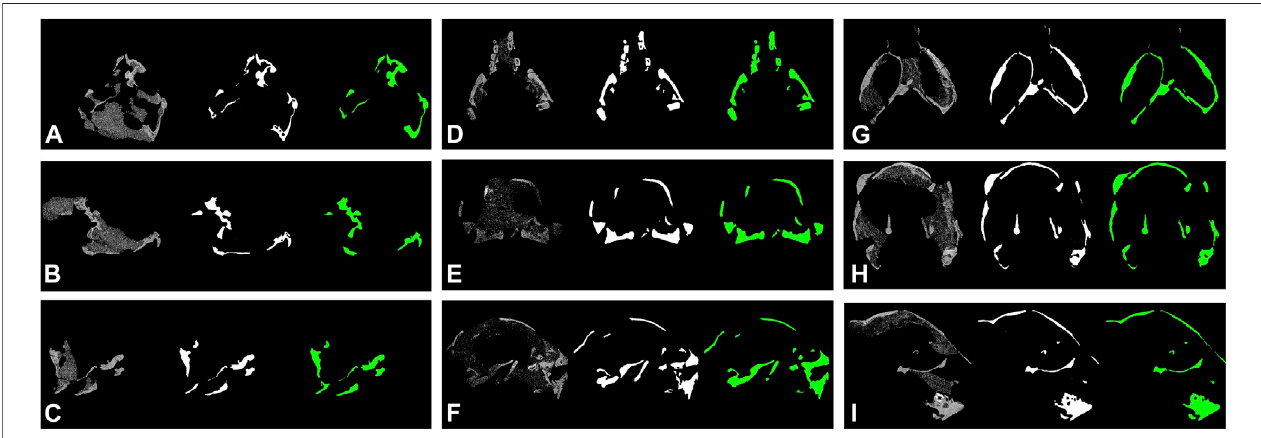
FIGURE 4 | Segmentation results of protoceratopsian dinosaurs by DeepLab v3+ with MobileNet v1 as feature extractor. In each sub fi gure, from left to right: original CT slice, groundtruth, and prediction by models. (A – C) . IGM 100/1021; (D – F) . IGM 100/3654; (G – I) , IGM 100/3655.